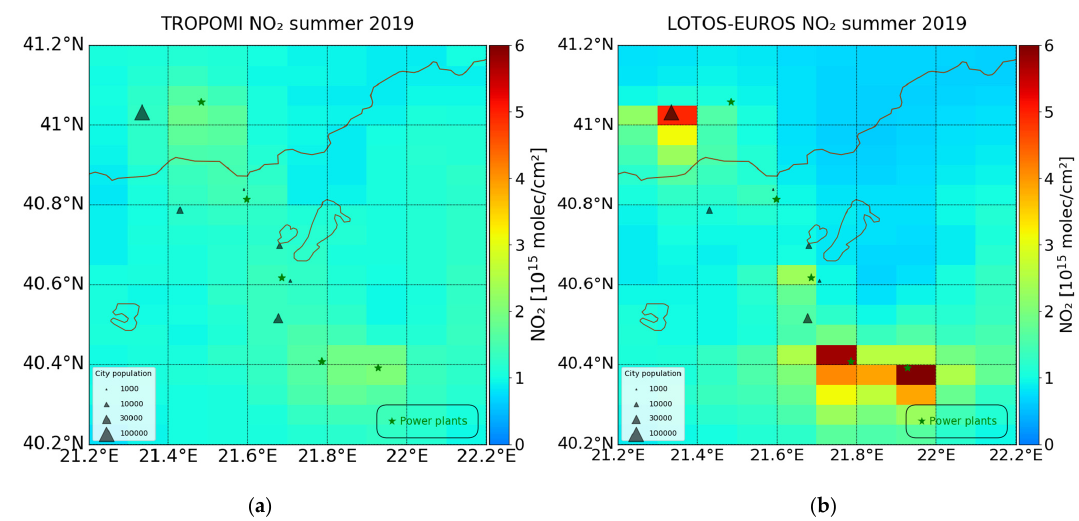
Figure 5. Seasonal averaged NO 2 tropospheric columns in the summer of 2019 ( a ) from S5P/TROPOMI ( b ) and LOTOS- EUROS CTM after the AK of the satellite product are applied.